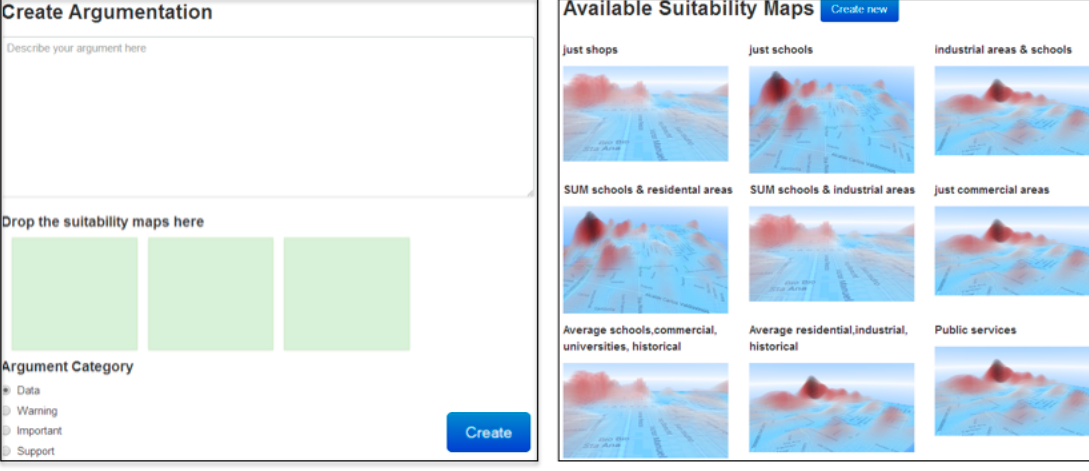
Figure 4. Left: Creating a new contribution to the debate. The argument text is introduced into the text area on the left . On the right , the available maps are displayed, which can be dragged and dropped on the areas under the